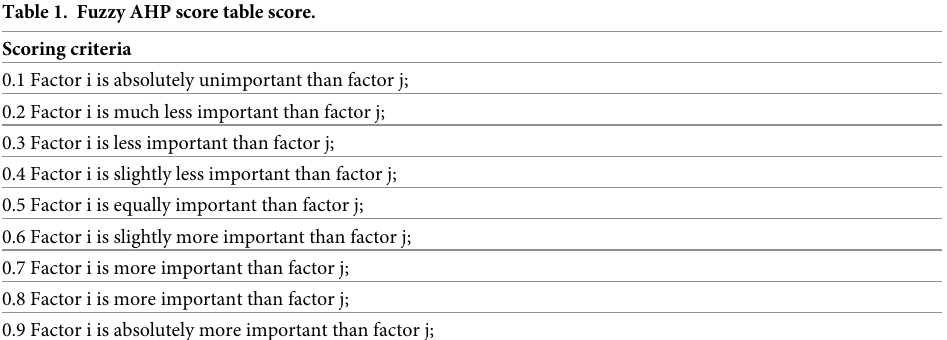
Table 1. Fuzzy AHP score table score. Scoring